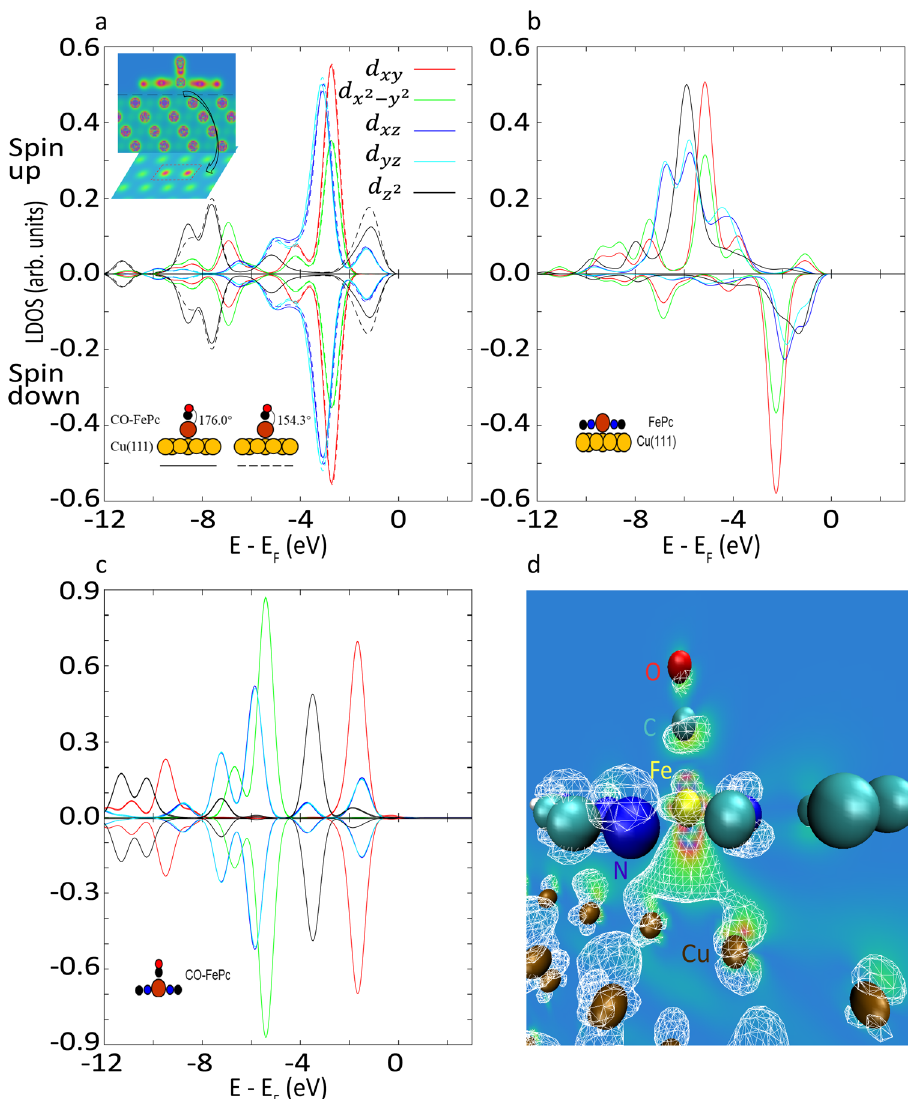
Fig. 5 The spin-polarized local density of states projected onto the center Fe atom. a CO-FePc on Cu(111) with two O-C-Fe angles, 176° (at equilibrium, solid curves) and 154° (manually rotated, Fe-C and C = O bond lengths are fi xed during rotation, dashed curves), net magnetic moment = 0.0 µ B . b FePc on Cu(111), net magnetic moment = 1.2 µ B . c CO-FePc without a substrate, net magnetic moment = 0.0 µ B . In a , the top inset shows a 2D vertical pro fi le of the total electron density across the Fe atom. The black arrow indicates a 2D horizontal pro fi le in between the complex and the Cu surface where the red dashed rectangle encloses the two bridge Cu atoms underneath the center Fe. d The HOMO of the system (around the center Fe atom). A wireframe view of the orbitals is overlapped with a 2D vertical pro fi le of the electron density. Electron density fi gures are presented in Red-Green-Blue scale (red/blue: higher/lower electron density). Isosurface value = 10 − 5 e/bohr 3